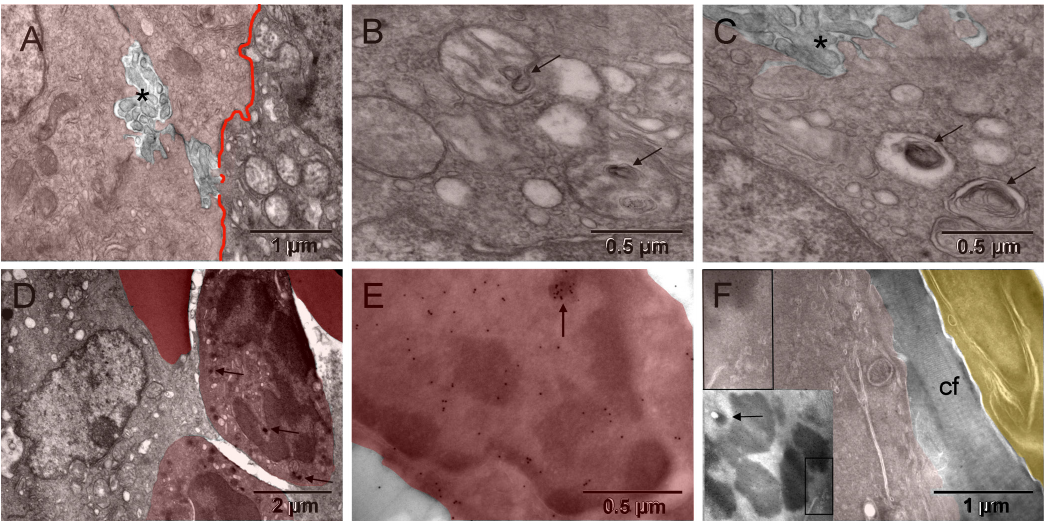
Figure S2. Hypoxia in tumor cells and involvement of host cells in forming the capsular vaso-mimicry. Hypoxia in tumor cells was manifested by structural changes of mitochondria resulting in their condensation into smaller and more electron dense (darker) forms or in degradation of cristae (left and right from the red line, respectively) [ A ], occasionally leading to autophagic vacuoles with whorls of membranes (arrows in [ B & C ]) or to peroxisomes (arrows in [ D ]). Partial separation of the tumor cells from one another (anoikis 58 ) with emergence of meandering nanotentacles (stars in [ A & C ], no color added) created intercellular passages and greatly increased the cell surface. Immunocytochemical detection of GFP-labeled histone H2B in tumor cell is shown in [ E & F ]. The tumor cell in [ E , light red] had nucleus with electron dense regions that did not contain H2B, except for a small upper region, demonstrating incomplete chromatin degradation (arrow). Upper left corner of [ F ] corresponded to the boxed area of the insert and showed H2B specific label in mitotic chromosome of the tumor cell (brown). A layer of collagen fibers (cf) separated that cell from the elongated fibroblast (yellow) with unlabeled nucleus (upper right corner) of [ F ]. Arrow in the insert points to a condensed mitochondrion.